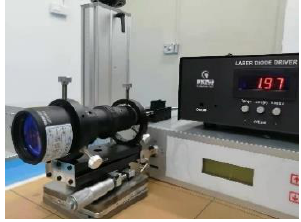
Figure 13. Laser collimation mode. Table 3. Voltage of the photovoltaic panels.